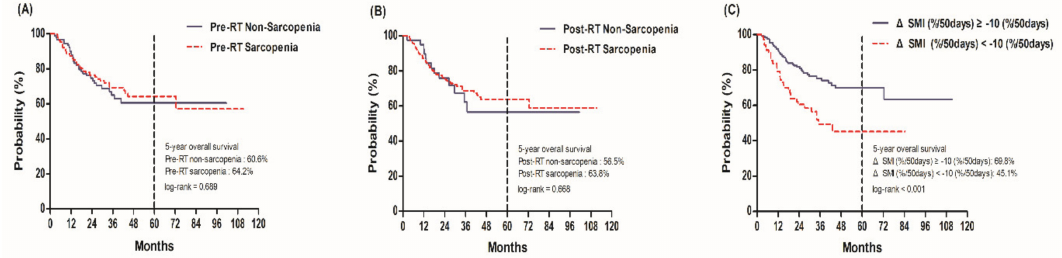
Figure 1. Overall survival between ( A ) Pre-RT non-sarcopenia vs. Pre-RT sarcopenia ( B ) Post-RT non-sarcopenia vs. Post-RT sarcopenia ( C ) ∆ SMI (% / 50days) ≥− 10.0 (% / 50days) vs. < − 10.0 (% / 50days).